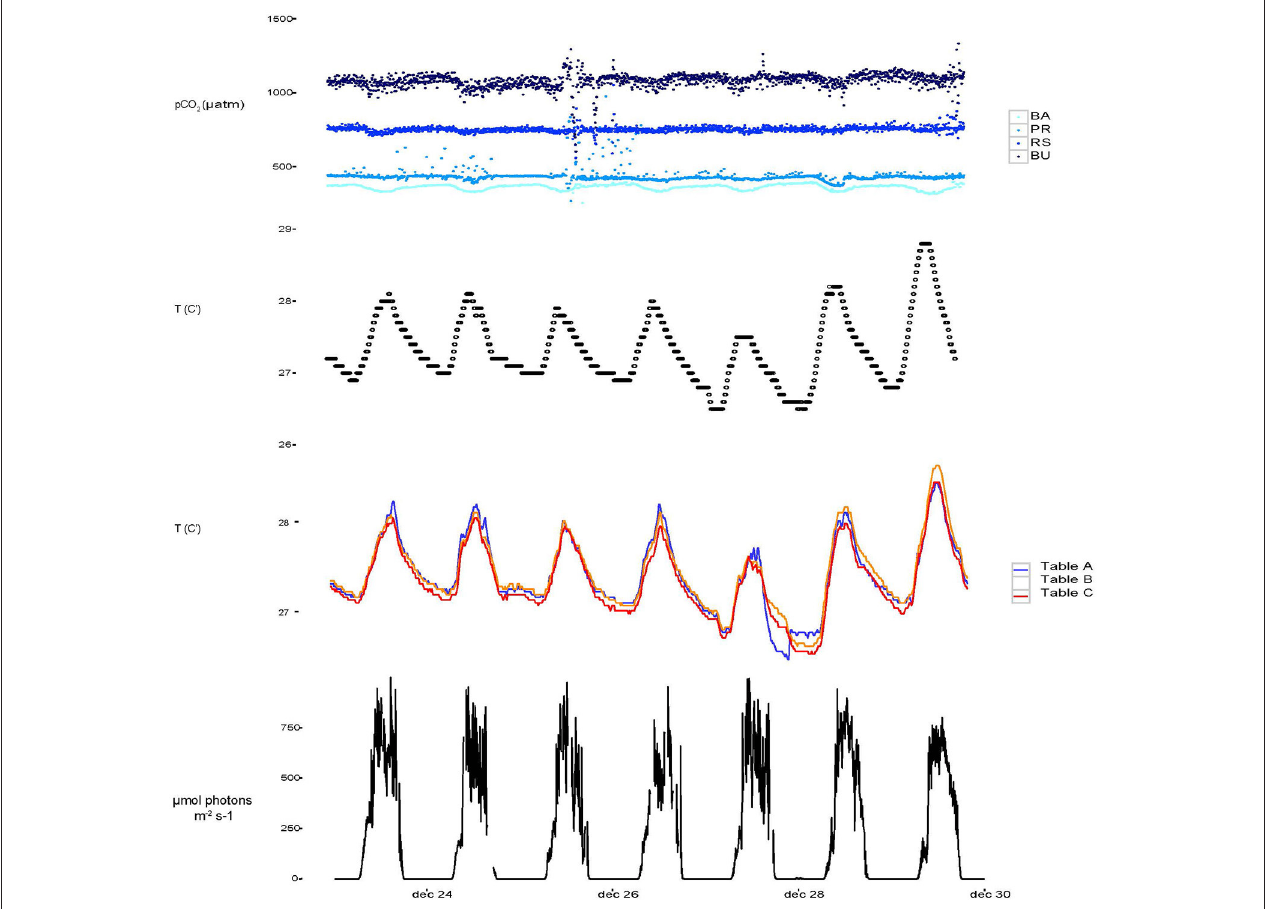
FIGURE 2 | Temporal variability from December 23 to December 30 2015 of continuously monitored p CO 2 (a), temperature monitored in the barrels used for setting the p CO 2 experiments (b), temperature measured directly in aquaria from table A, B, and C (c) and light throughout the 1 week experiment.